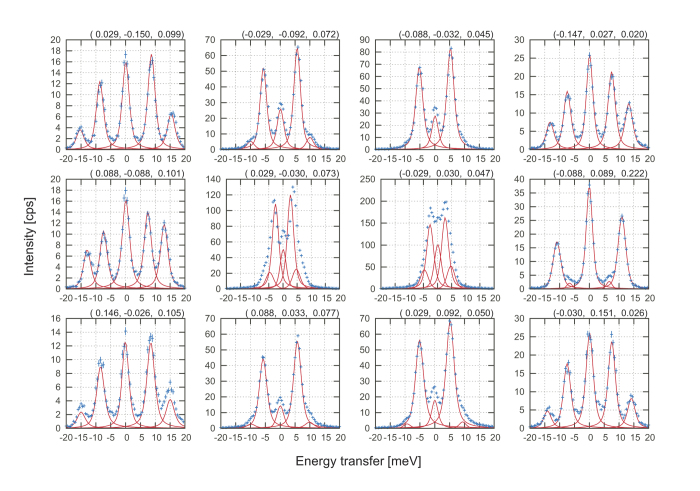
A representative set of IXS spectra of (Fe,Al)-Bdg collected at BL35XU.Twelve spectra can be measured at once. Reduced q positions in reciprocal lattice unit are shown in parentheses. A total momentum transfer was (2, −2, 0) + q in reciprocal lattice unit. Each spectrum show one or two pairs of clear phonon signals. Blue crosses show data points. Red lines show pseudo-Voight functions fitted to peaks.